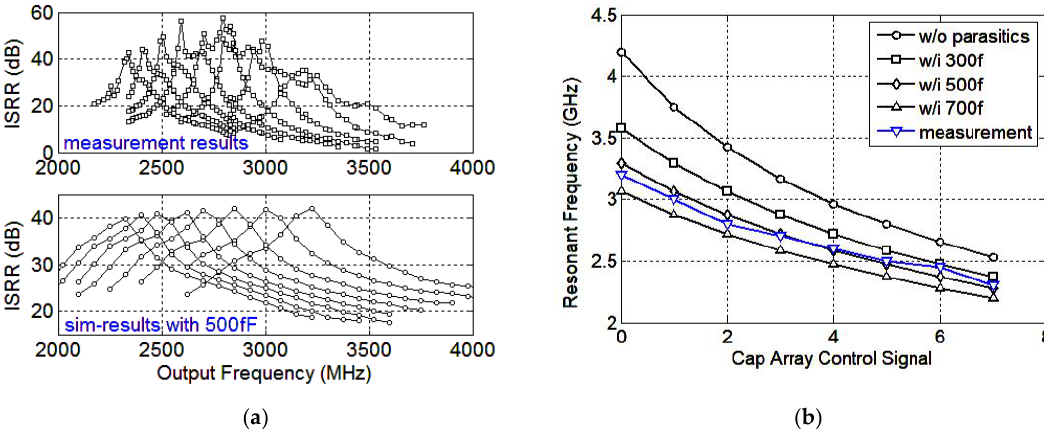
Figure 15. ( a ) ISRR measurement and simulation results versus the output frequency; ( b ) resonant frequencies versus the mixer cap array control signals.